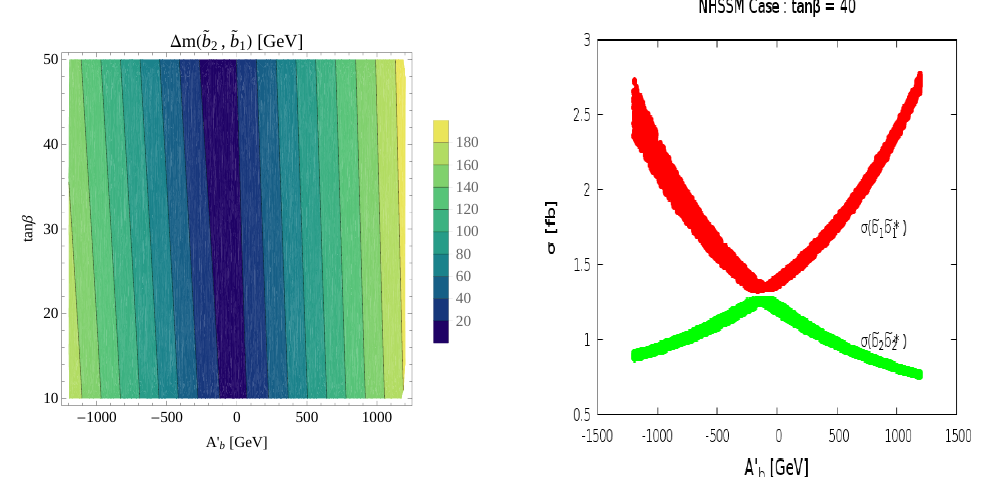
Figure 11 . Contours of constant (cid:1) m (~ ~ b ~ b (cid:3) ; ~ b 2 ~ b (cid:3) ) as functions of A 0 1 1 2 m ~ =1.2 TeV. Other (cid:12)xed parameters are A b = 0, (cid:22) = 200 GeV, (cid:22) 0 = 0, A t = 2 TeV, M 1 = 500 GeV b R and M 2 = 1 : 1 TeV.